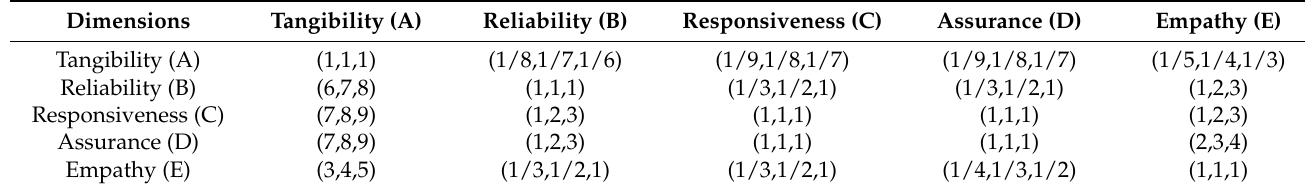
Table 4. The fuzzy pairwise comparison matrix of dimensions from FANP model.